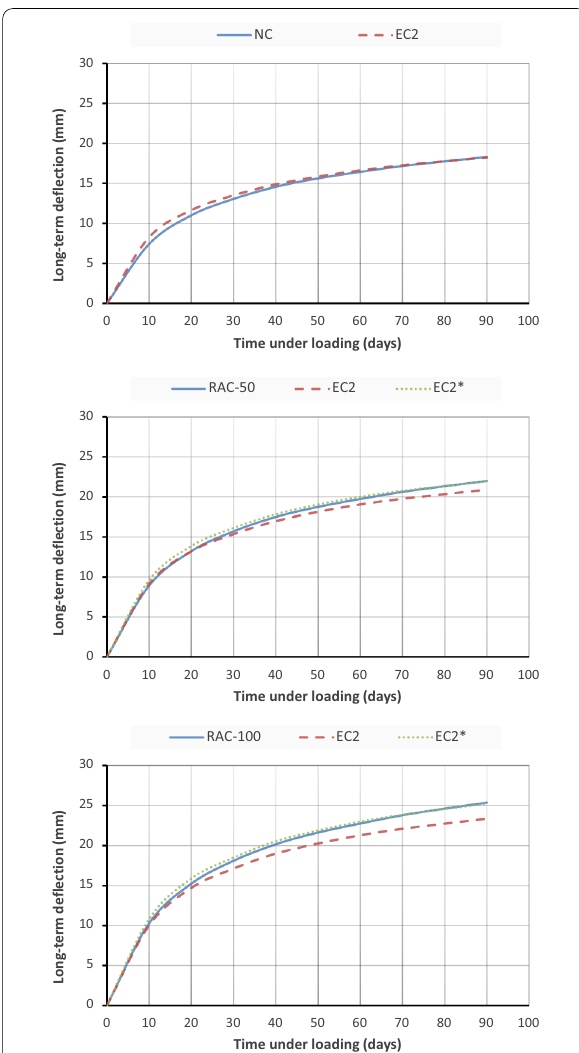
Fig. 12 Comparison of the experimental and predicted long-term deflection results of tested beams